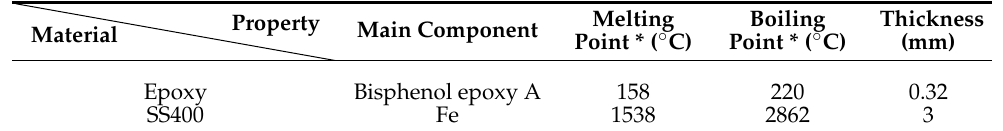
Table 1. Properties of the experimental